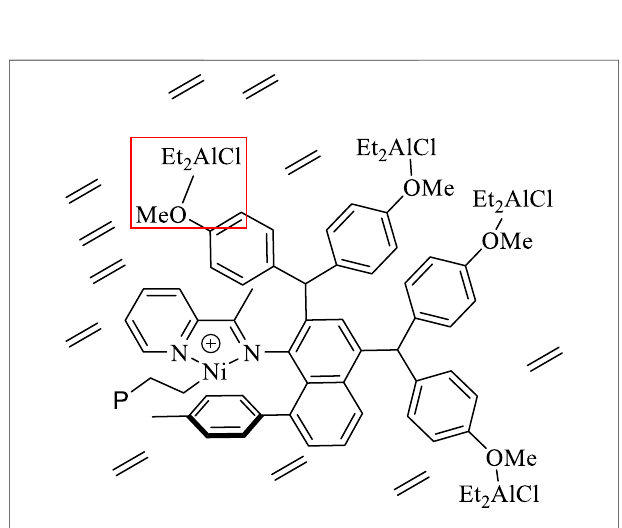
FIGURE 6 | The interaction of OMe with the co-catalyst (Et 2 AlCl) to form a greater axial steric hindrance.